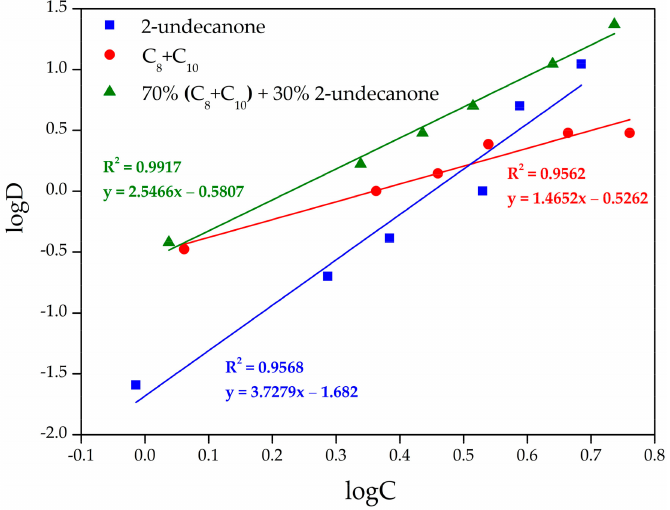
Figure 6. Log–log relation between the distribution coefficient Fe(III) and extractant concentration at C(HCl) = 5.7 M, C(Fe) = 8.4 g/L, O:A =